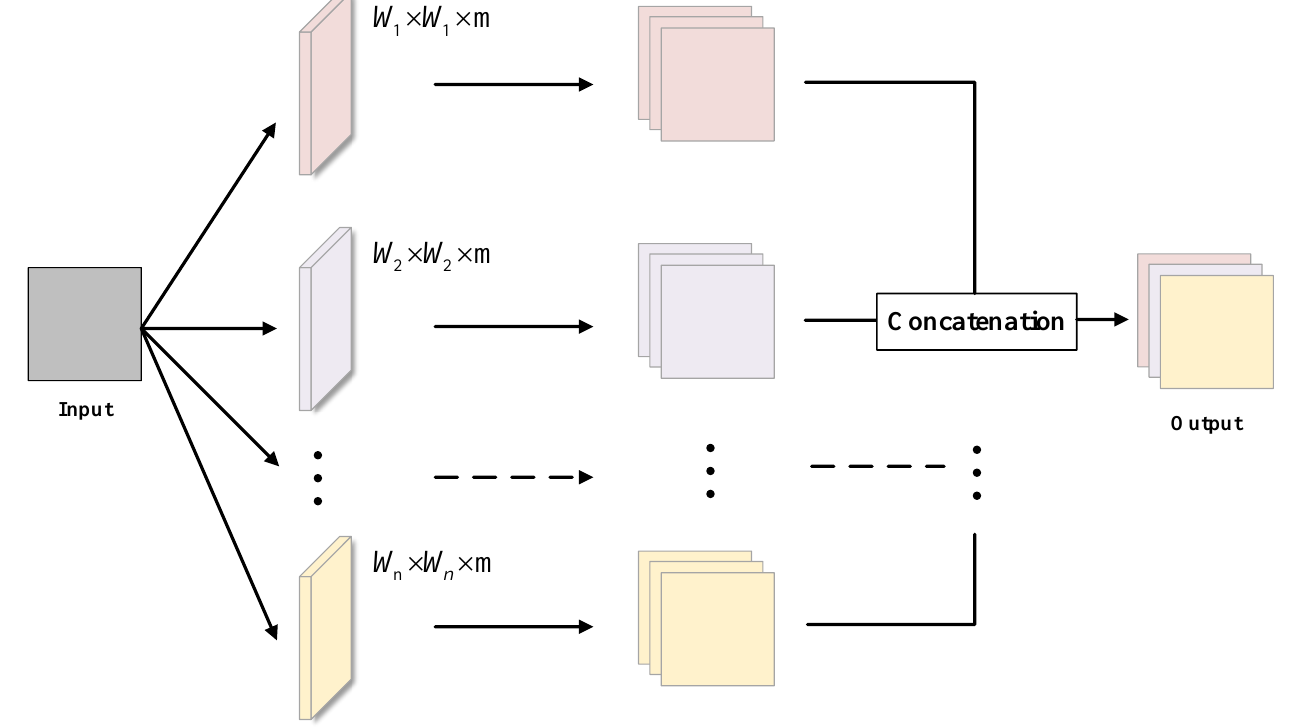
Figure 1. The structure of the multi-scale convolutional network.